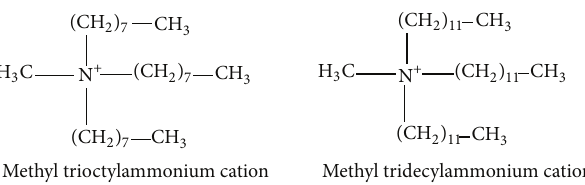
Figure 1: The cations of Aliquat 336.